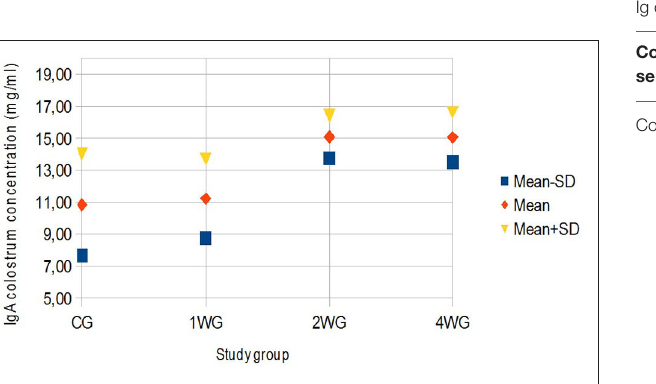
FIGURE 3 | Variability of colostrum IgA concentration depending on study group. Results are presented as mean ± SD. CG, control group; 1WG, one-week group; 2WG, two-week group; 4WG, four-week group. Each study group enrolled 5 bitches.